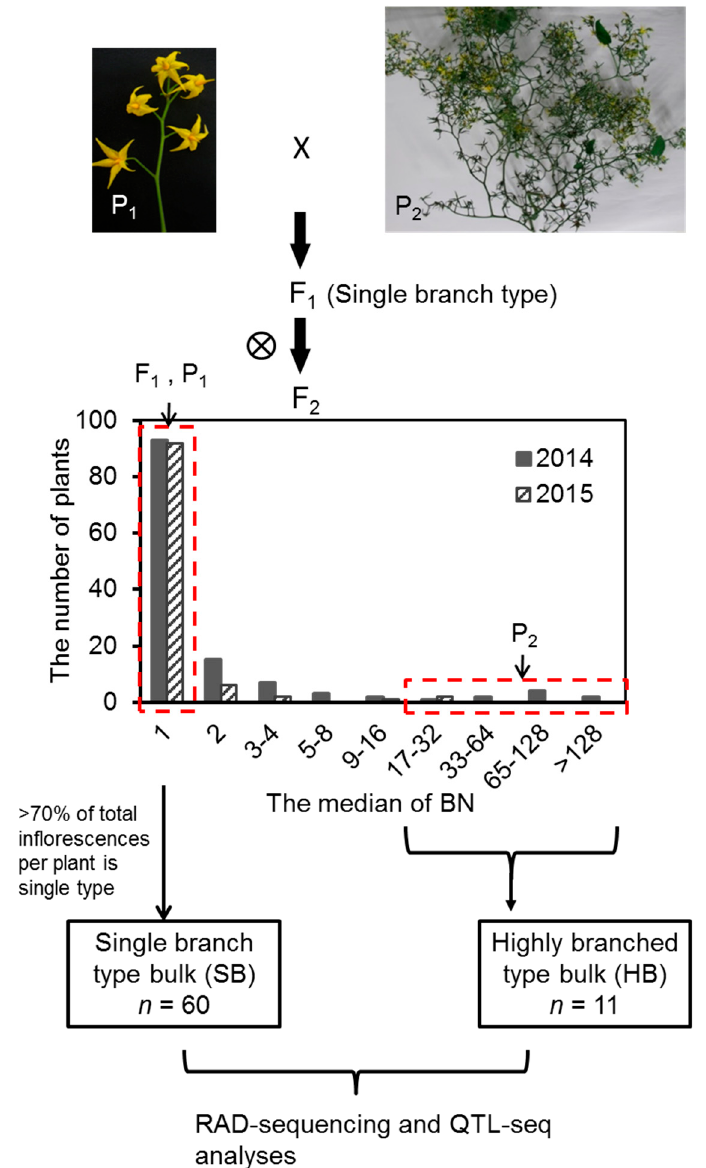
Figure 1. Flowchart of the BN QTL detection. The F 2 populations were constructed from a cross between highly-branched inflorescence type 10AS111A and the single-branch inflorescence type PI124039. Because the BN of inflorescence was not consistent along the stem within one plant, we defined the single branch type as the plant in which the median of BN was one and more than 70% of the inflorescences were single-branch inflorescences. If the median of BN was more than 16, they were categorized as highly-branched plants. Sixty plants with single -ranch inflorescence and 11 plants with highly-branched inflorescence grown in 2014 were pooled and used for RAD sequencing and QTL-seq analysis. A histogram of F 2 populations across the years shows the number of plants bearing different numbers of branched inflorescences is shown. P 1 : Solanum pimpinellifolium PI124039; P 2 : S. lycopersicum 10AS111A; F 1 : The F 1 derived from P 1 and P 2 . The arrows indicate the BN of F 1 , P 1 and P 2 , averaged for the two-year experiments. ⊗ means self-crossing.